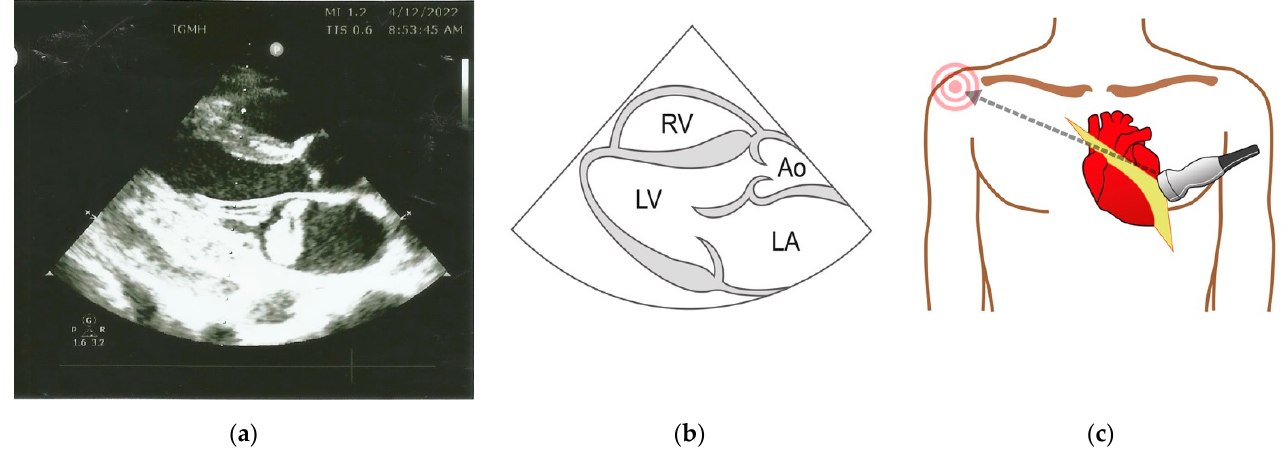
Figure 3. ( a ) Two-dimensional echocardiogram showing a large echogenic mass in the left atrium. ( b ) Normal anatomical landmarks seen in the long axis view (RV, right ventricle; LV, left ventricle; LA, left atrium; Ao, aorta). ( c ) Parasternal position of the probe for transthoracic echocardiography.